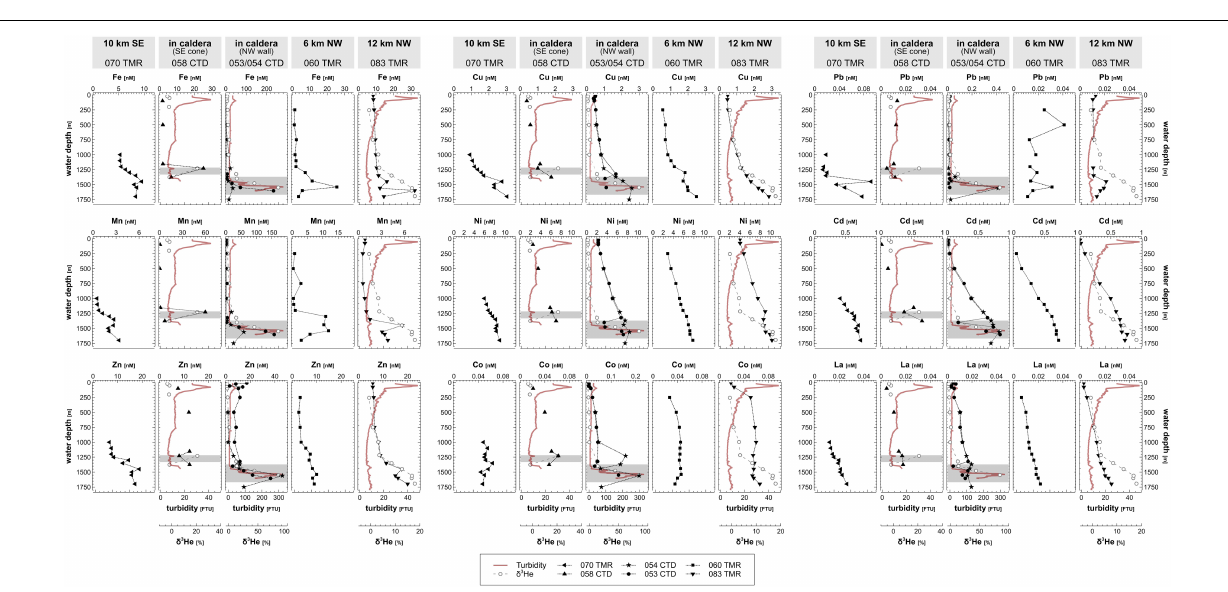
toward the northwest, compared to the southwest,